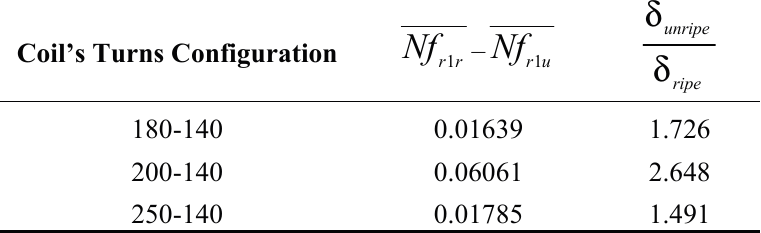
Table 6. Differences between and the ratio between δ unripe and δ ripe for the first peak.